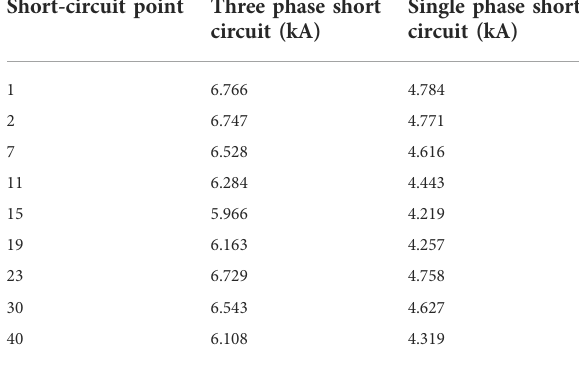
TABLE 5 Short-circuit current of three-phase short circuit and single- phase short circuit of typical nodes. Short-circuit